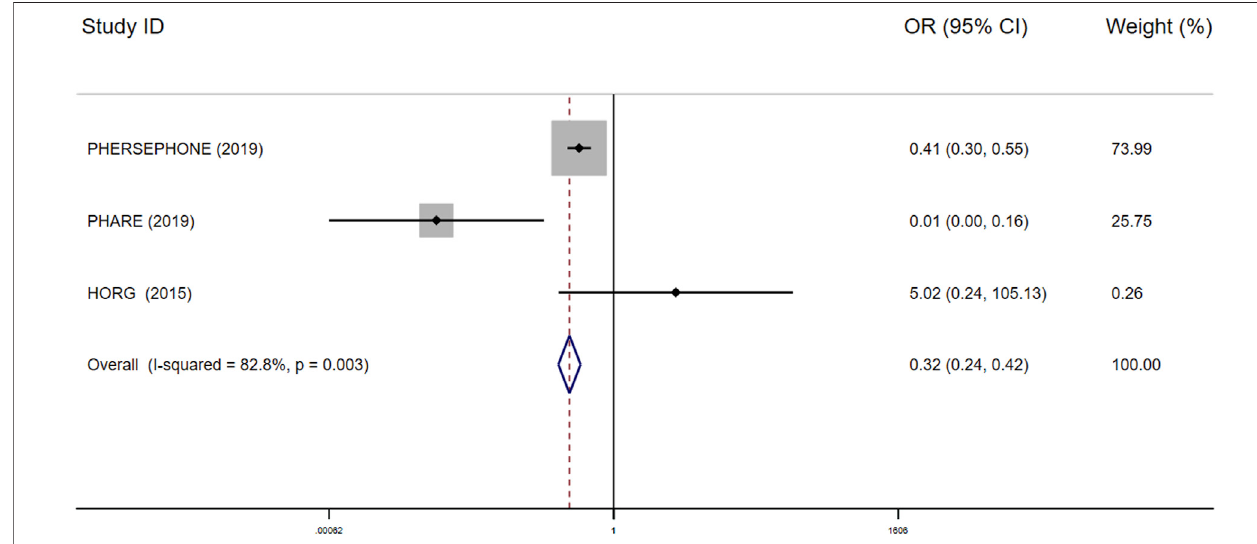
FIGURE 5 | Forest plot of the effect of short-duration interventions for decreasing occurrence of trastuzumab discontinuation in breast cancer patients receiving trastuzumab.